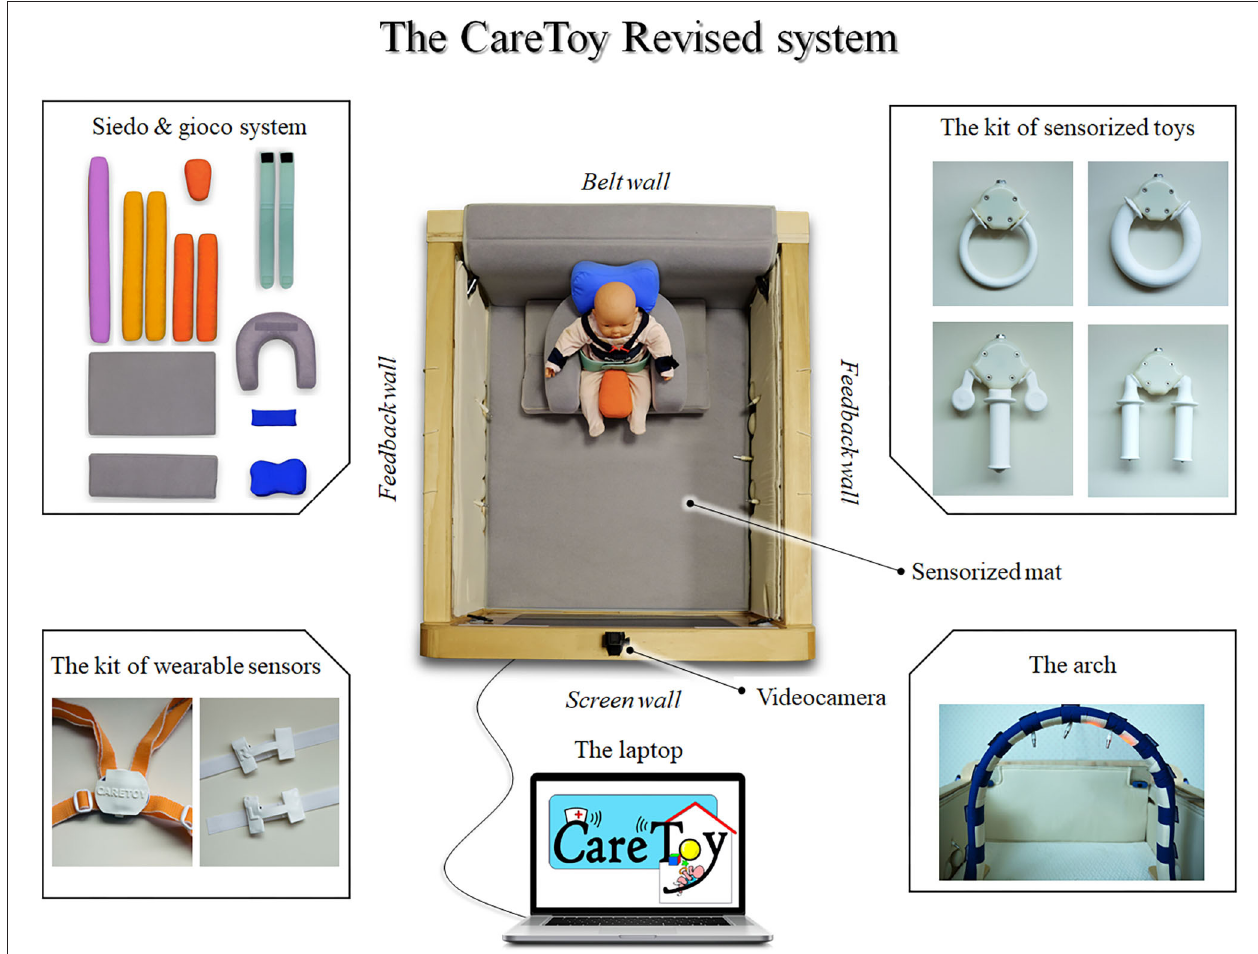
FIGURE 1 | The CareToy-R